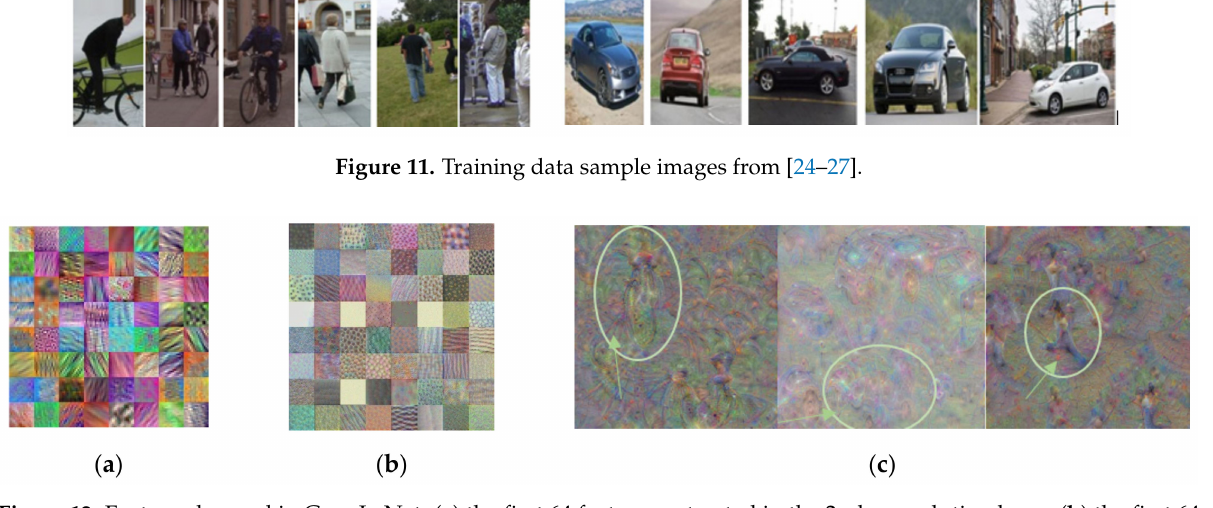
Figure 12. Features learned in GoogLeNet: ( a ) the first 64 features extracted in the 2nd convolution layer; ( b ) the first 64 feature output in the 1st inception module; ( c ) the three outputs in the last fully connected